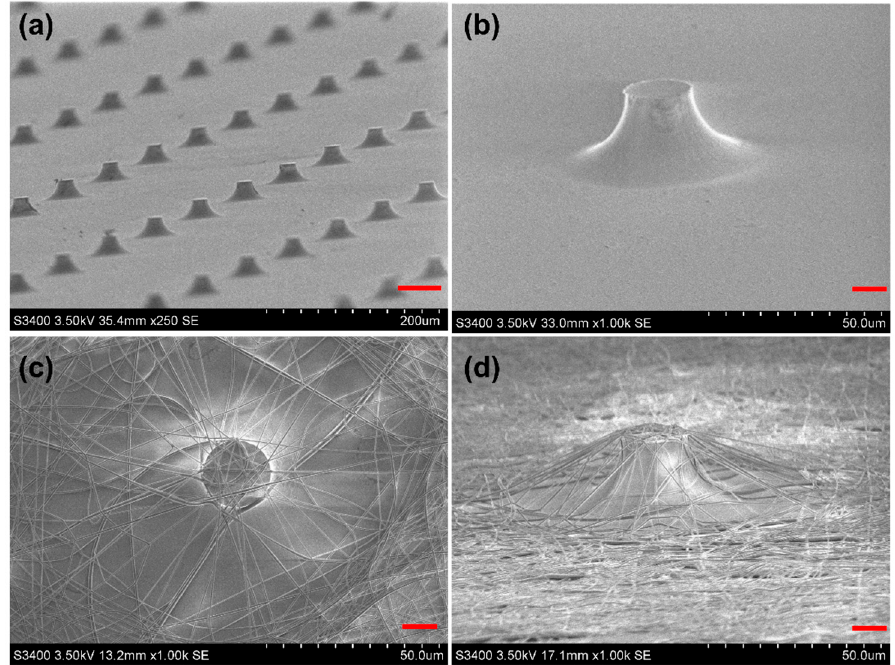
Figure 3. SEM images of the chemical wet-etched micropillars and the PLGA nanofibers. ( a , b ) Chemically wet-etched micropillars. The scale bar in ( a ) is 50 μ m. ( c , d ) Electrospun PLGA nano- fibers. The scale bars in ( b – d ) are 10 μ